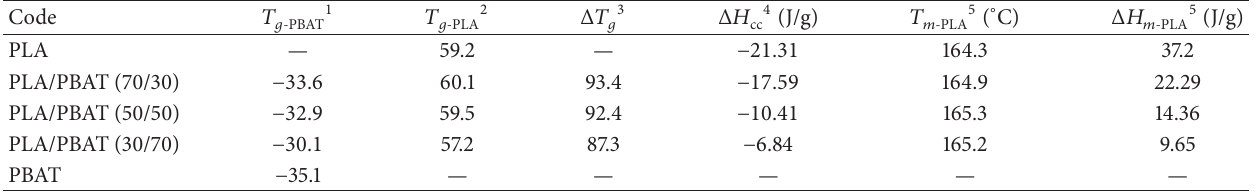
Table 2: Characteristic temperatures of phase transition and enthalpy values of PLA/PBAT blends in the melt-quenched scan of DSC.